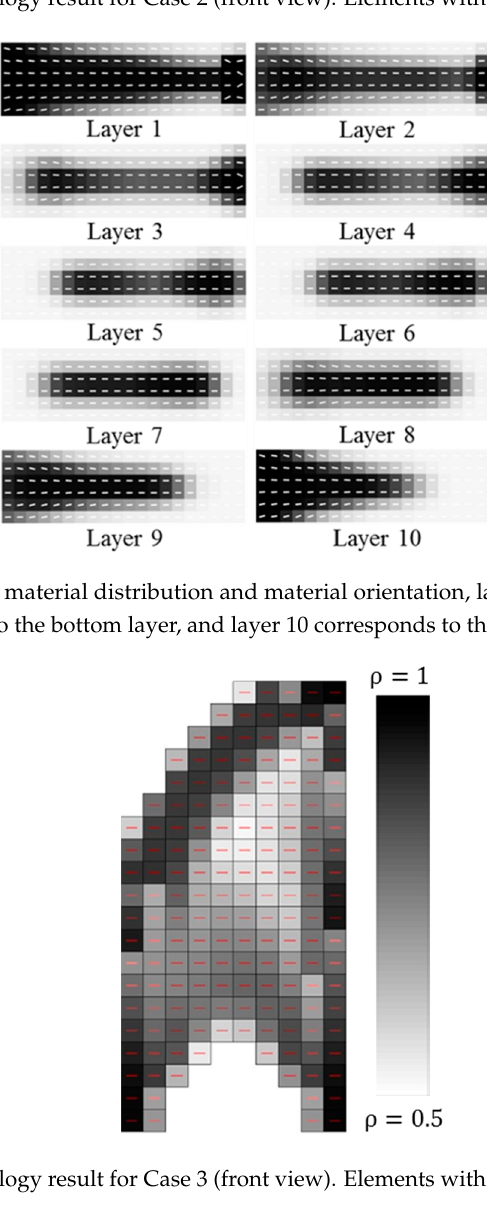
Figure 16. Optimized material distribution and material orientation, layer-by-layer plots for Case 3. Layer 1 corresponds to the bottom layer, and layer 20 corresponds to the top layer. Table 4. Topology result comparisons between Case 1, Case 2, and Case 3. Case Study